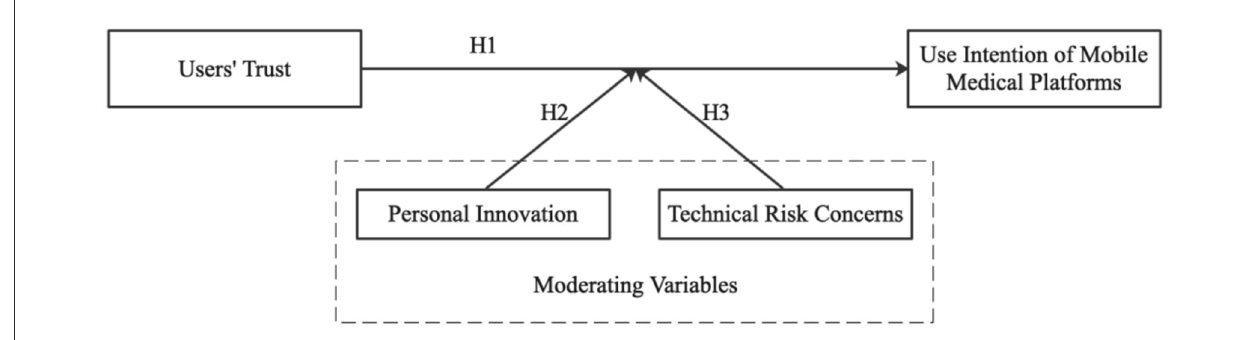
FIGURE1 Conceptual framework of the